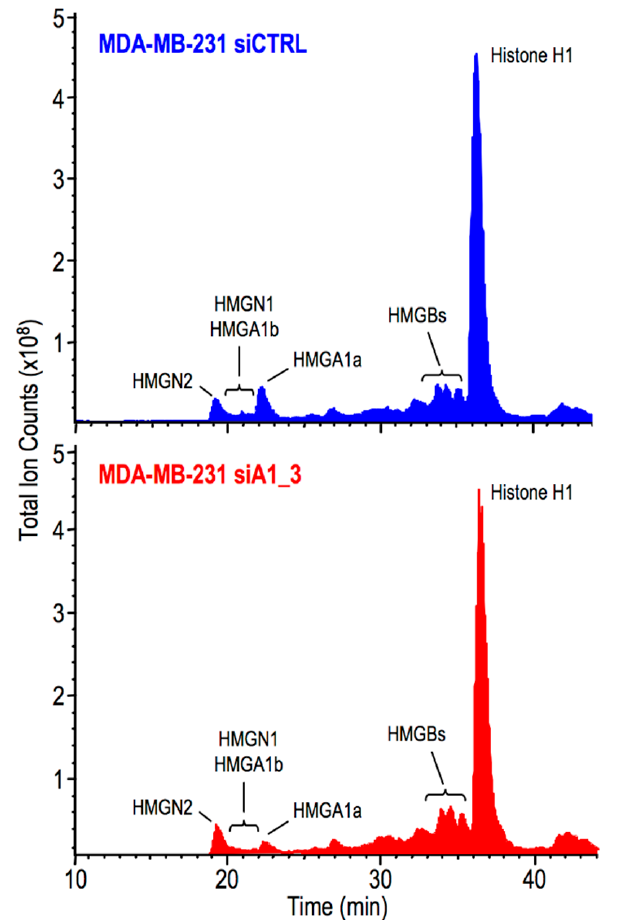
Figure 3. LC-MS analyses of HMGs and histone H1 variants. Comparison of total ion chromatograms (TICs) obtained by LC-MS analyses of MDA-MB-231 treated with siCTRL or siA1_3. The peaks within each chromatogram of HMGN2, HMGA1b, and HMGN1, HMGA1a, HMGBs, and histone H1 variants are indicated.